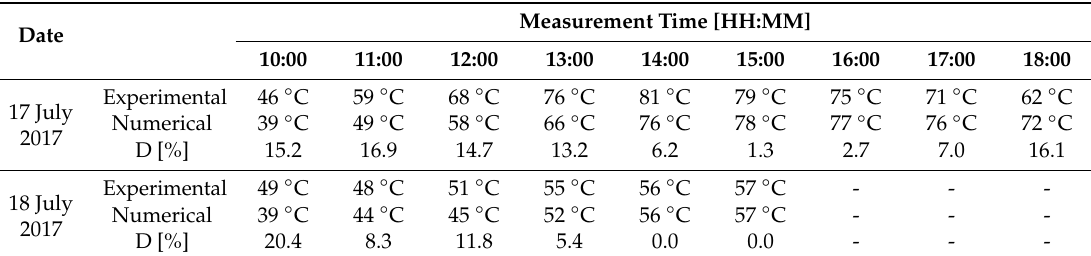
Table 6. Comparison of solar cells average temperature on surfaces for the covered and uncovered CPC system by experimental characterisation (TCD) and numerical simulation (CM) with relative discrepancy.